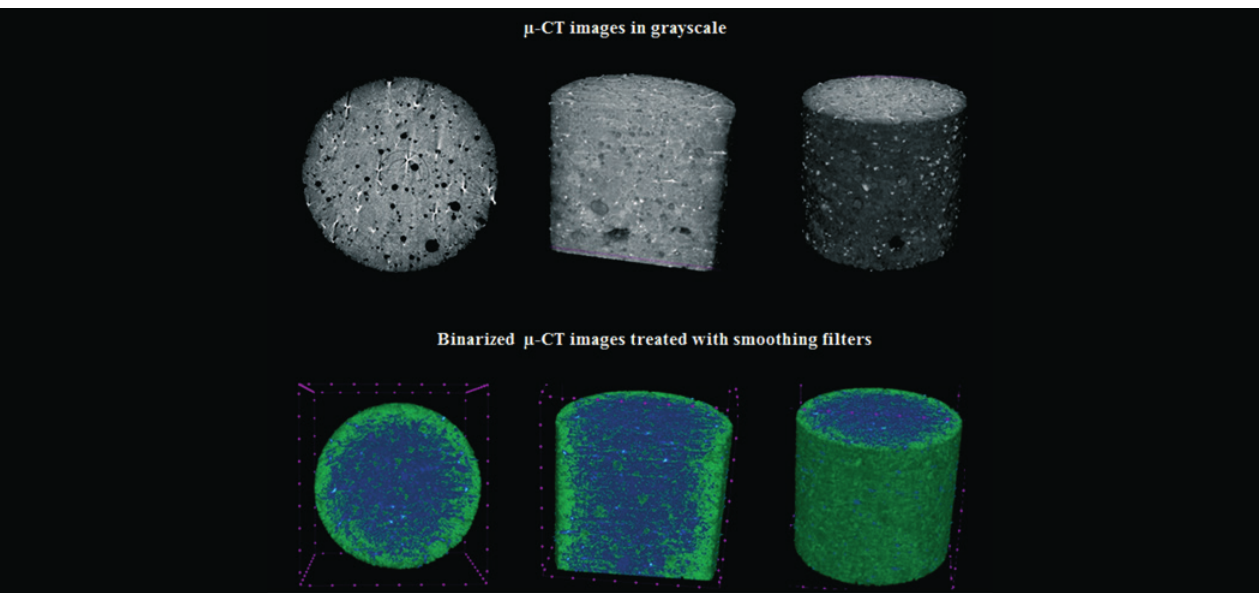
µ-CT images of a specimen after 14 days of exposure in the carbonation chamber